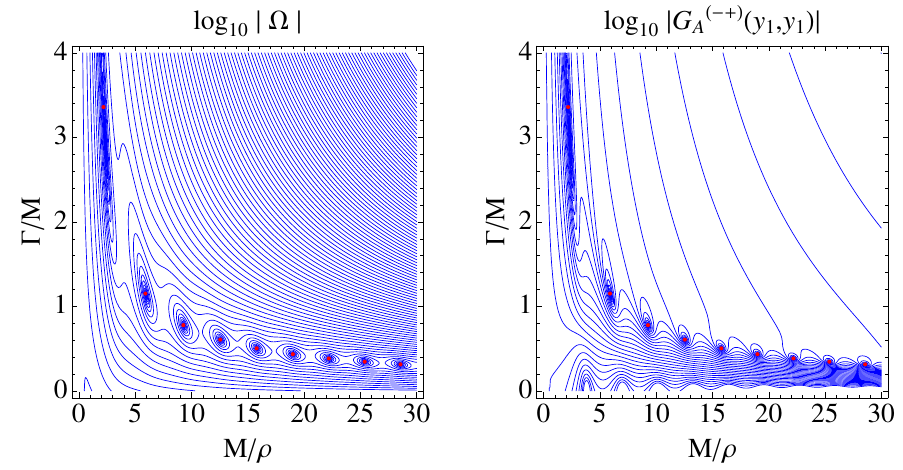
Figure 10 . Plots of the IR-to-IR Green’s function | G ( − +) panel), G ( − +) ( y 1 , y 1 ; | p | ) /G ( − +)0 for p 2 < 0 (middle panel), and the rescaled spectral function A A F 11 · ρ ( − +) ( y 1 , y 1 ; p ) (right panel) as functions of p/ρ . We have used A 1 = 35 in all panels. A